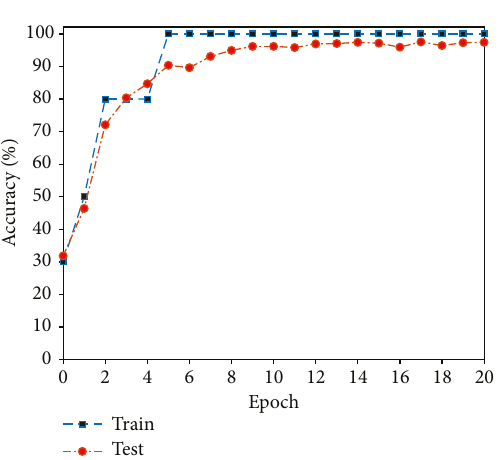
Figure 9: Proposed DCNN architecture.